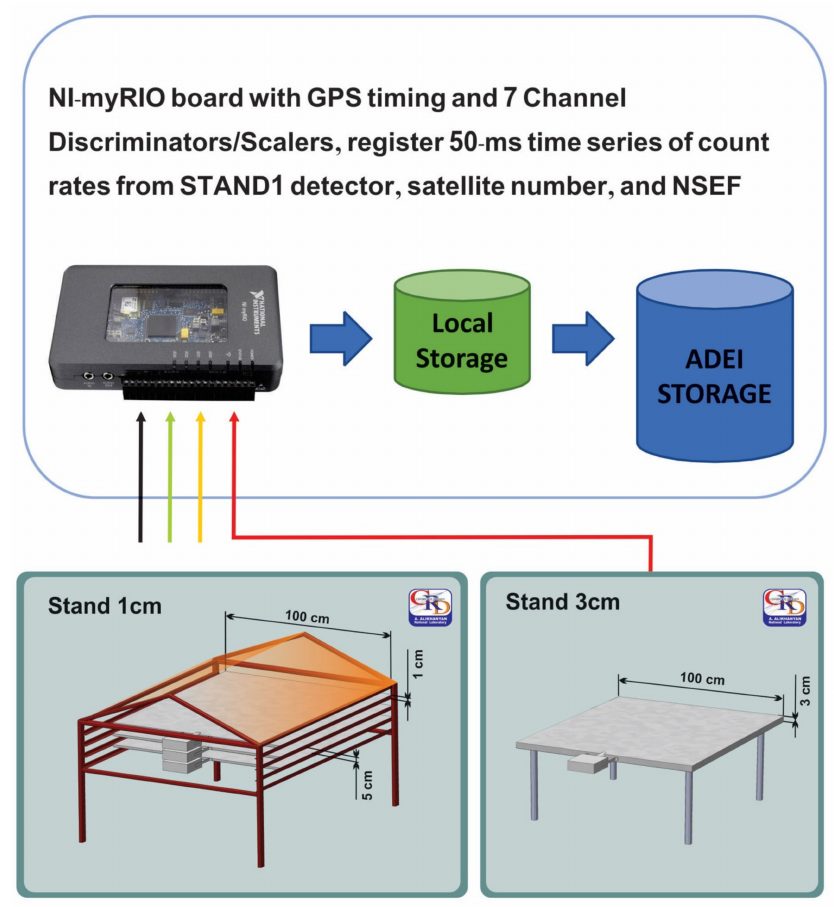
Figure 2. Fast data acquisition system for the STAND1 network units (three of the same